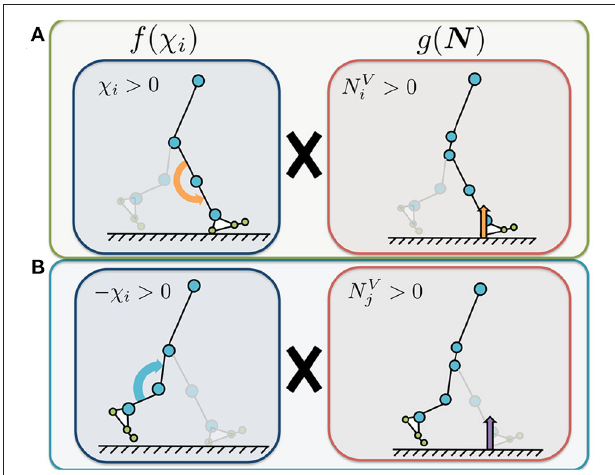
FIGURE 5 | Illustrated definition of the Tegotae function for the ankle controller. The control variable ψ i represents the control command that increases or decreases the target angle of the ankle joints. We use ψ i to adjust the target angle for the ankle controllers. N H i represents the sum of the horizontal force sensor values corresponding to the heel, metatarsal, and toe joints of the corresponding leg. N V j represents the sum of the vertical force sensor values corresponding to the opposite leg. (A) Tegotae function for corresponding-leg sensory information. The value of N H i ψ i is positive when the foot sensors on the corresponding leg detect a large horizontal GRF ( N H i > 0) and the command for the ankle is plantar flexion (i.e., ψ i > 0). (B) Tegotae function for opposite-leg sensory information. The value of N V j ( − ψ i ) is positive when the foot sensors on the opposite leg detect a large vertical GRF ( N V j > 0) and the command for the ankle is dorsal flexion ( ψ i <